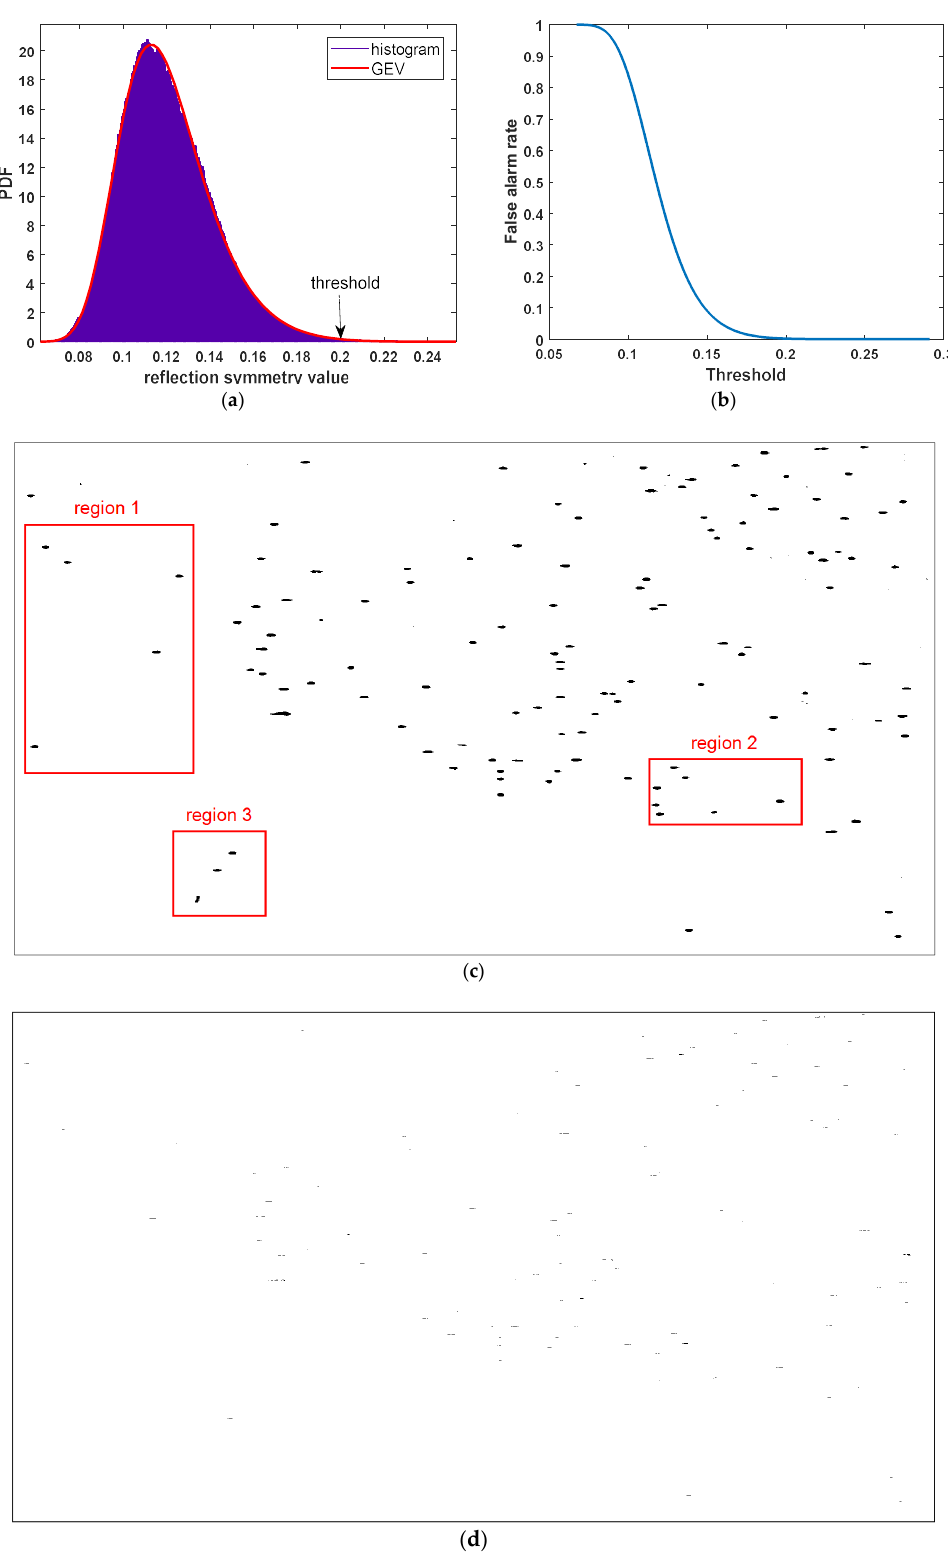
Figure 7. Data set 2: ( a ) PDF of normalized reflection symmetry and the fitted statistical distributions; ( b ) curve shows the relationship between false alarm rate and threshold; ( c ) GEV-based CFAR detection result on the reflection symmetry; ( d ) CFAR detection result on the VH